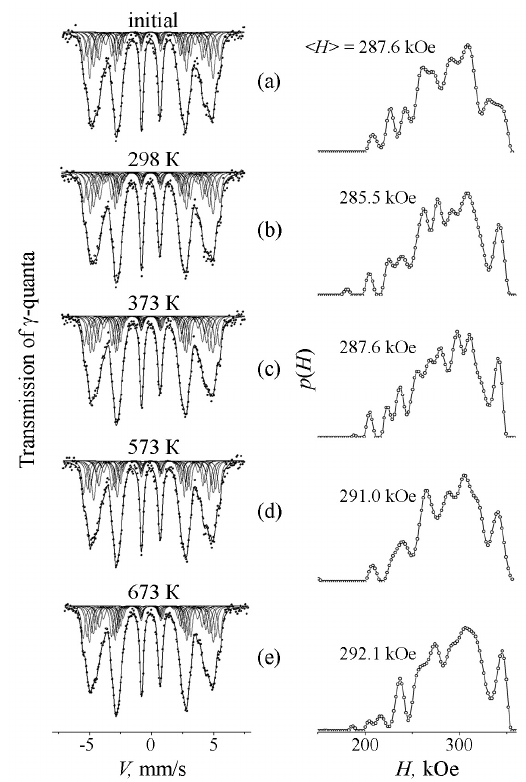
Figure 1. Mössbauer spectra, distributions p ( H ), and values of < H > for the alloy Fe-16Cr in the initial state and after—HPT ( ε = 5.9, n = 3 rev.) at different temperatures: ( a )—initial state (annealed at 1073 K, 4 h); ( b )—HPT at 298 K; ( c )—HPT at 373 K; ( d )—HPT at 573 K, and ( e )—HPT at 673 K. Mössbauer spectra were measured at room temperature.